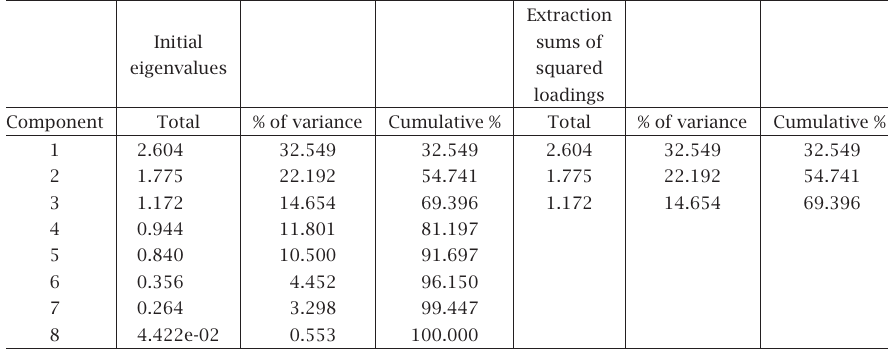
Table 3.1 . The total variance explaination of PCA.